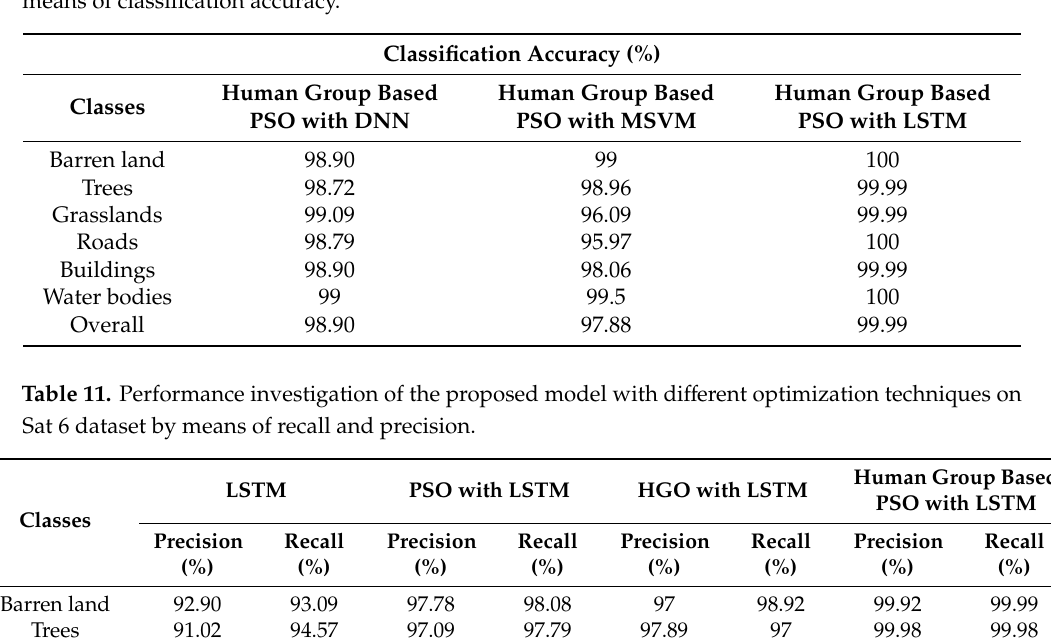
Table 10. Performance investigation of the proposed model with di ff erent classifiers on Sat 6 dataset by means of classification accuracy.